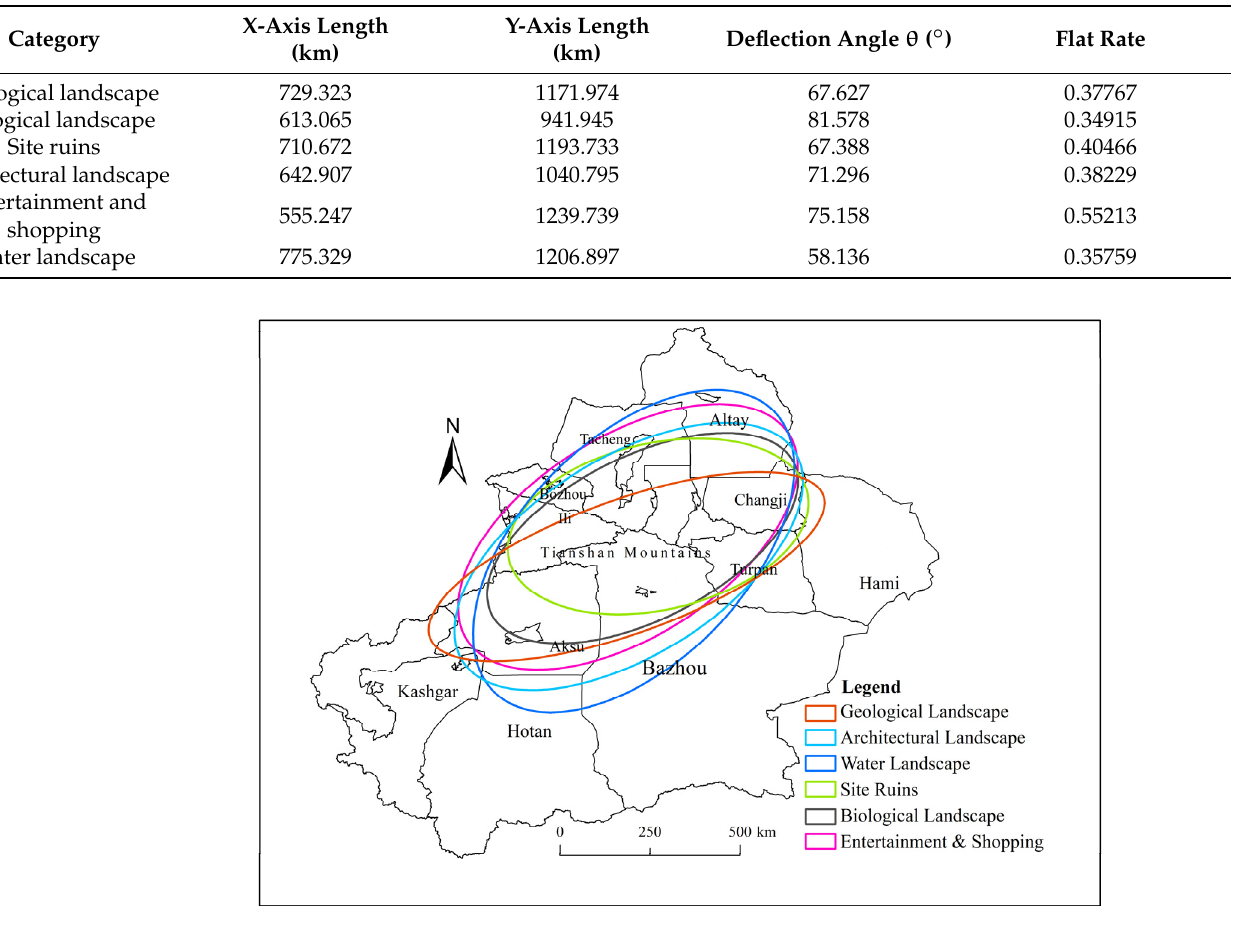
Figure 4. Standard deviation ellipses of different tourism resource categories in Xinjiang.